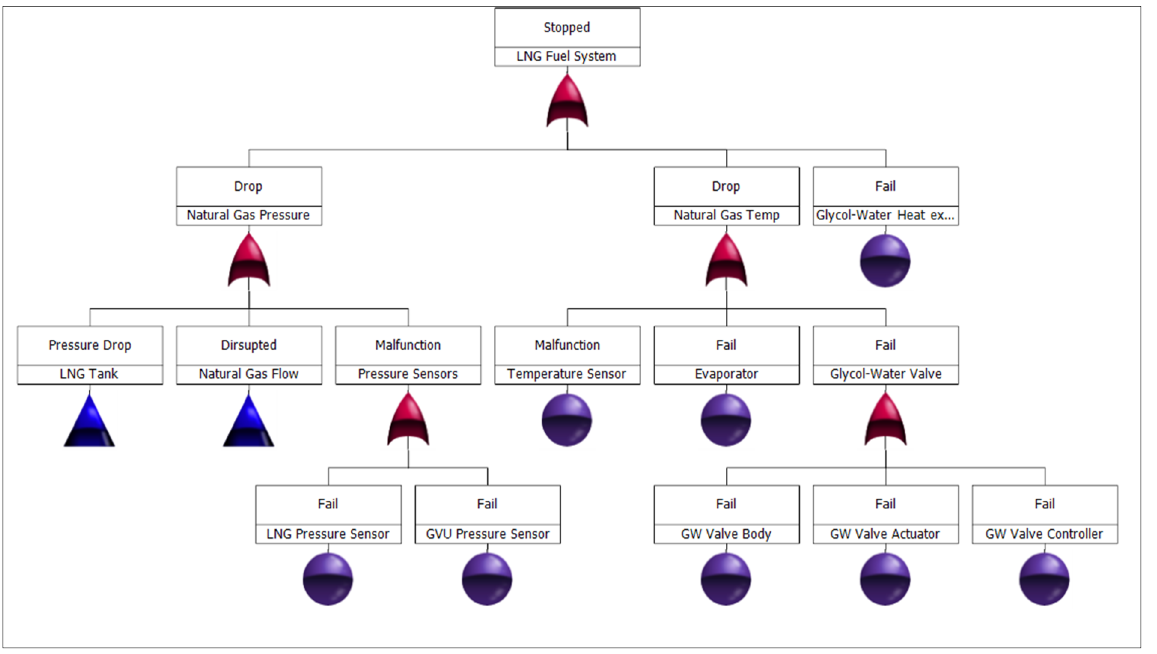
Figure 9. Baseline system configuration Fault Tree developed in PTC Windchill for the top event (c) (fuel system shut down).